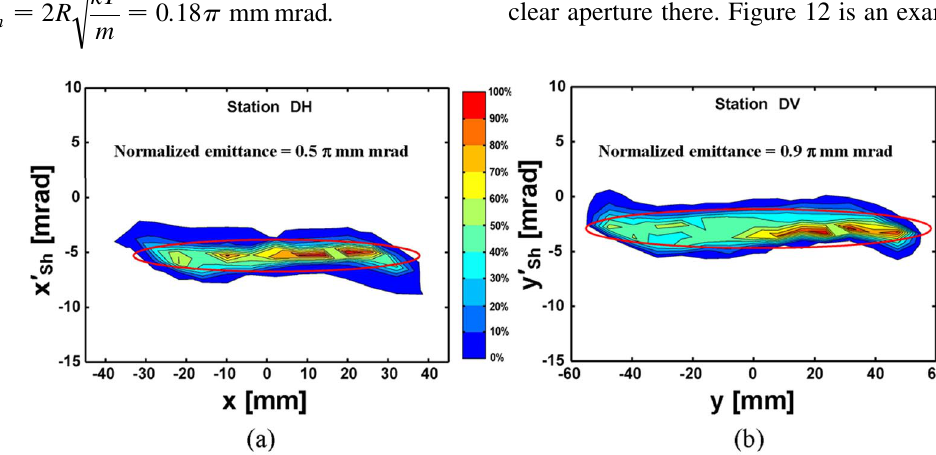
FIG. 10. (Color) Vertical single-slit current density profiles taken at the exit of the injector (a) before final optimization of the diode [summed over ( t (cid:5) 0 : 96 (cid:2) s , 3 : 2 (cid:2) s after the leading edge of the beam current pulse ( * the diode (summed over ( t (cid:5) 0 : 96 (cid:2) s , 3 : 12 (cid:2) s after start). The summation of the data is done over a short portion of the flattop of the beam current pulse. The red parabola is the equivalent profile for a uniform density beam with the same RMS beam size as the data. The step size is 1 mm for both measurements. Single-slit profiles are measured 22.6 cm downstream of the Kapton film location.